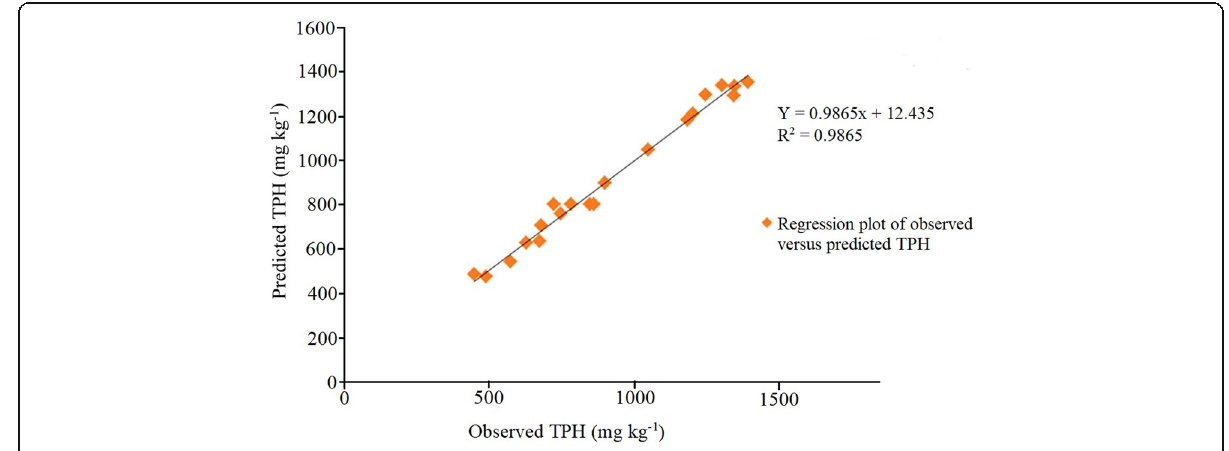
Fig. 4 Reliability plot of observed versus predicted TPH